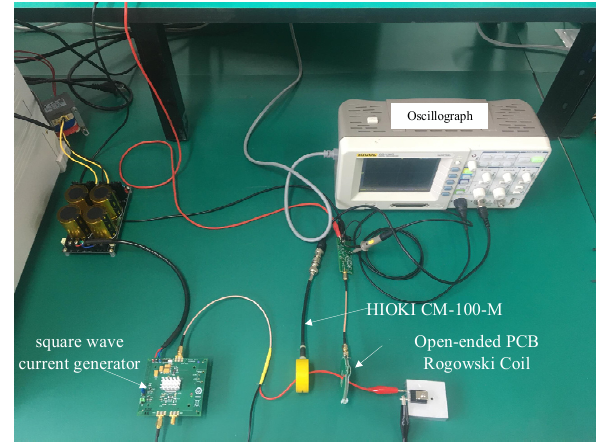
Figure 18. Field diagram of square wave test platform.